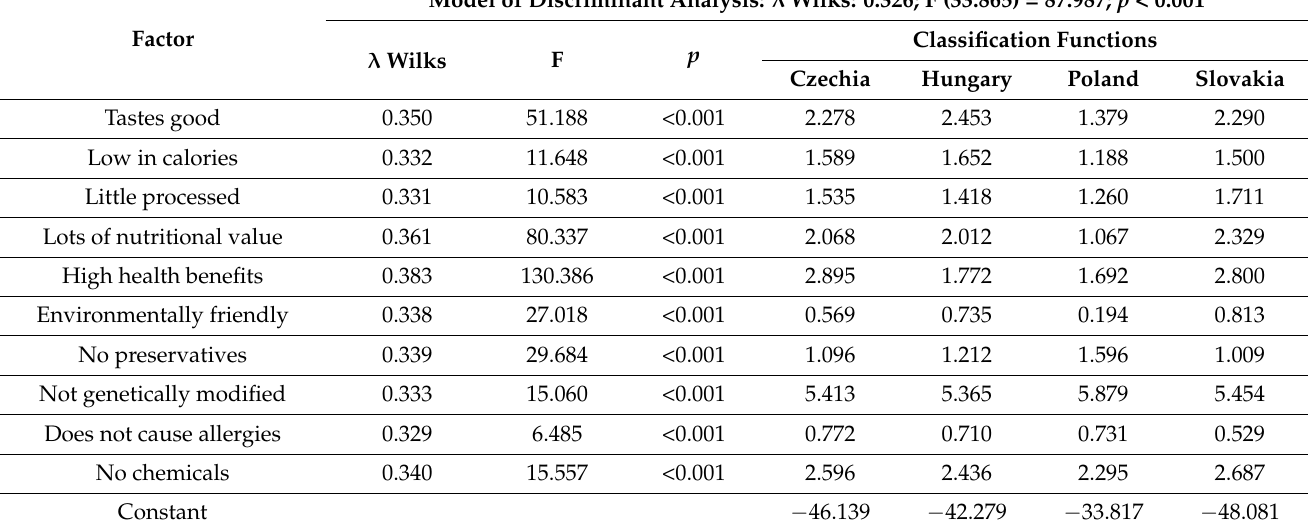
Table 3. Reasons for purchasing organic